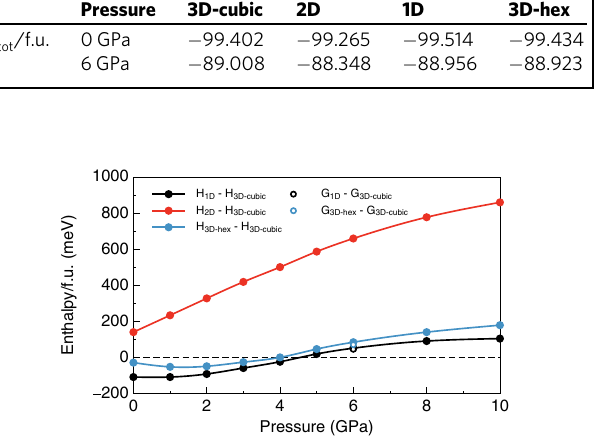
Table 1 Total enthalpy per formula unit H the relaxed structures under 0 and 6 GPa.